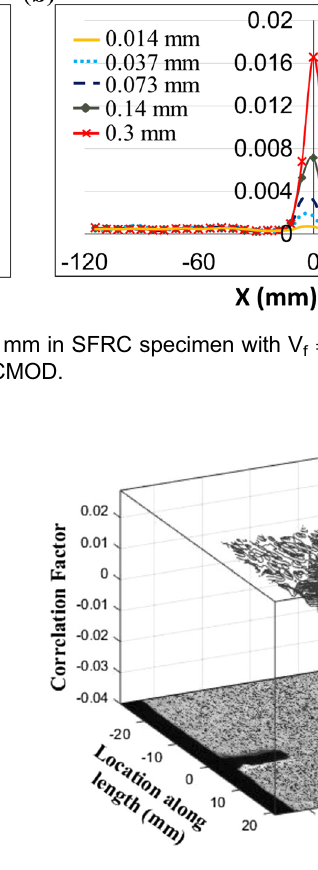
Fig. 6 Contours of correlation coefficient at Load Point 5 (CMOD = 0.3